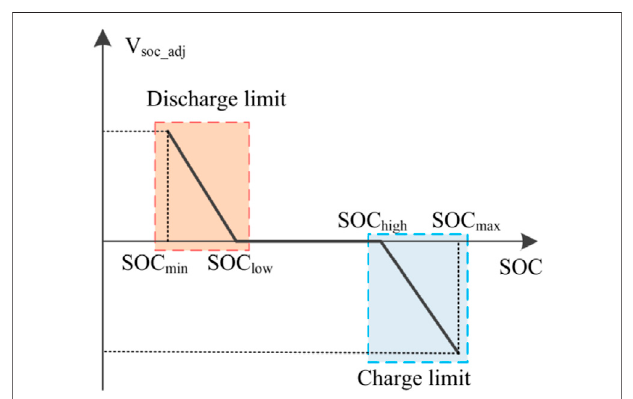
FIGURE 8 | Piecewise linearization regulation model based on